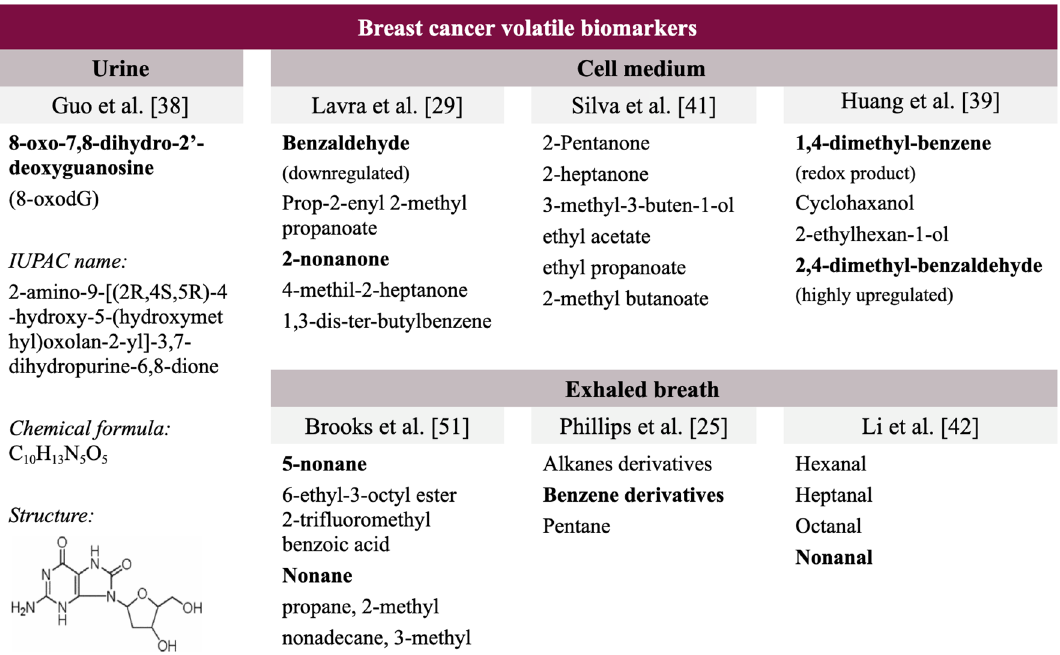
Figure 7. Summary of some VOCs encountered in urine, cell medium and expired breath, according to Guo et al. 27 , Lavra et al. 29 , Silva et al. 40 , Huang et al . 38 , Brooks et al. 50 , Phillips et al. 25 and Li et al. 41 . Those VOCs whose evidence was found to be more consistent and their derivatives have been highlighted.